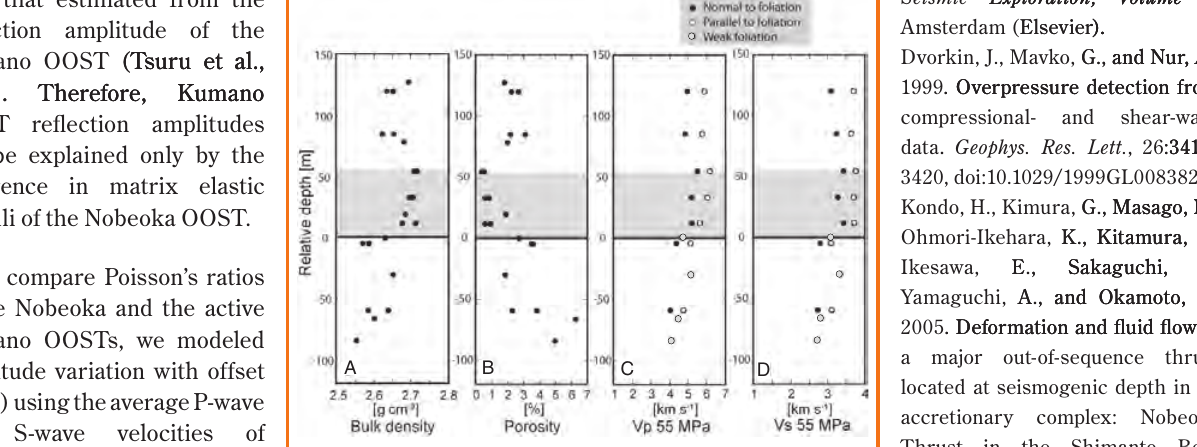
Figure 3. Depth profiles of [A] bulk densities, [B] porosities, [C] P-wave velocities at 55 MPa, and [D] S-wave velocities at 55 MPa (Tsuji et al., 2006). Vertical axis represents depth relative to the location of fault core. Black solid dots, open dots, and gray dots represent acoustic properties normal to the foliation, parallel to the foliation, and weak foliation, respectively. Black lines and gray zones represent locations of the fault core and the high velocity interval, respectively.